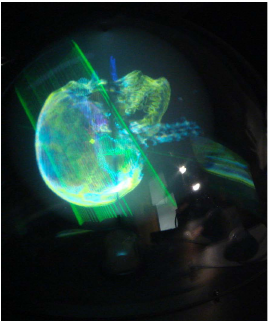
Figure 3. “PerspectaRAD mouse Phantom” by Gregg Favalora. Licensed under CC BY-SA 3.0 via Commons.